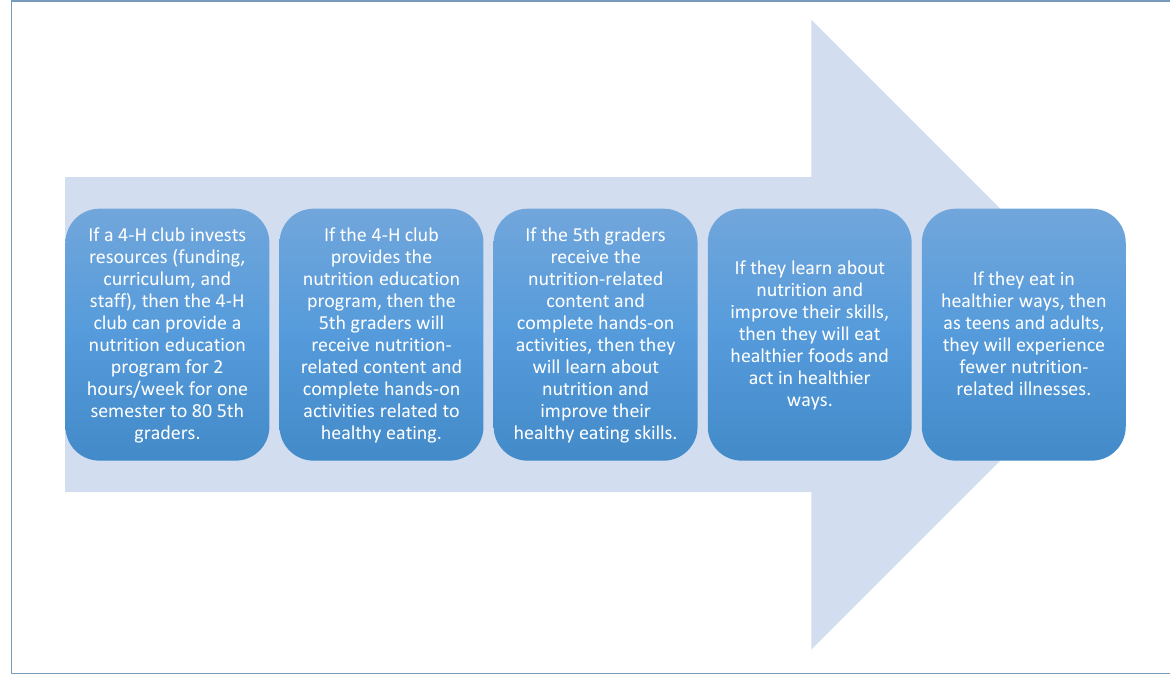
Figure 2. Example of Developing a Theory of Change through a Series of If-Then